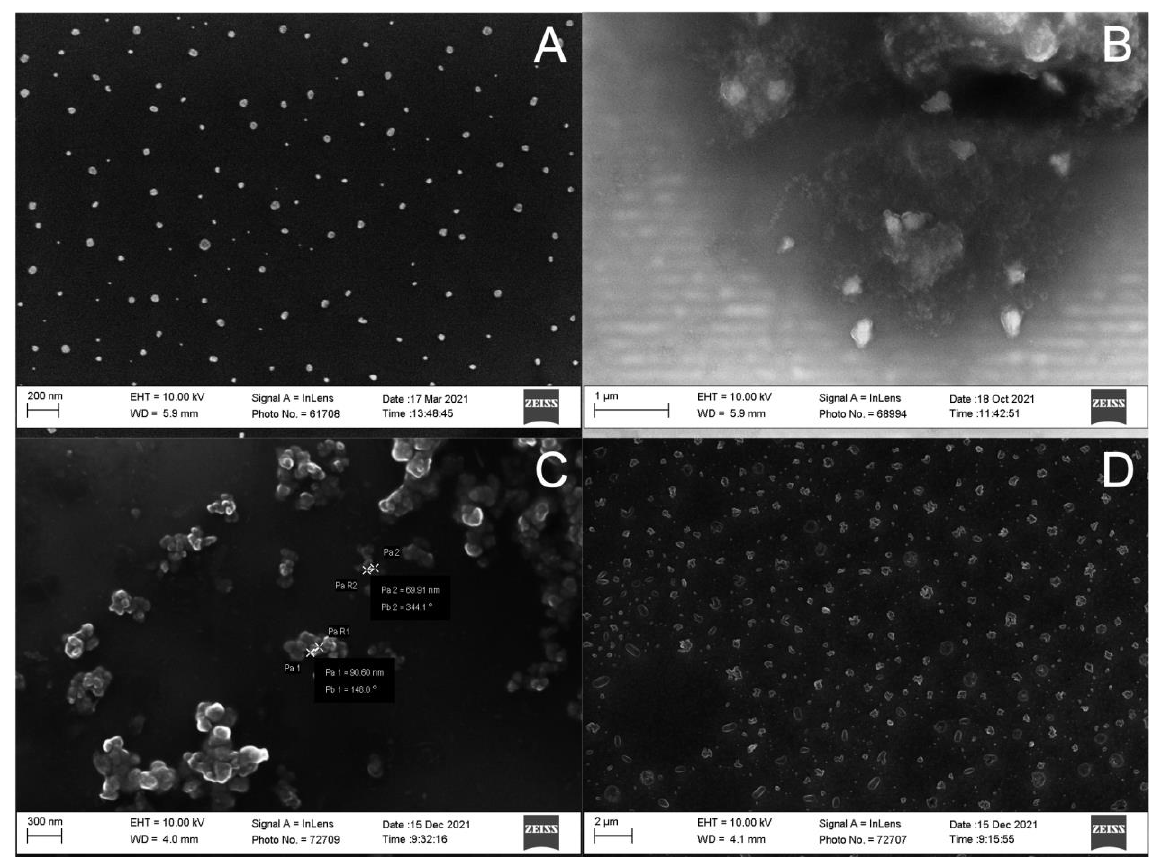
Figure 8. Scanning electron microscope images of alginate nanoparticles synthesized with the wa- ter-in-oil emulsification method. ( A ): 0.5 mg/mL alginate and 0.6 mg/mL Ca 2+ (E1). ( B ) 2.5 mg/mL alginate and 0.6 mg/mL Ca 2+ (E3). ( C ) 2.5 mg/mL alginate and 0.6 mg/mL Ca 2+ with ethyl acetate wash (E7). ( D ) 5.0 mg/mL alginate and 0.6 mg/mL Ca 2+ (E8).